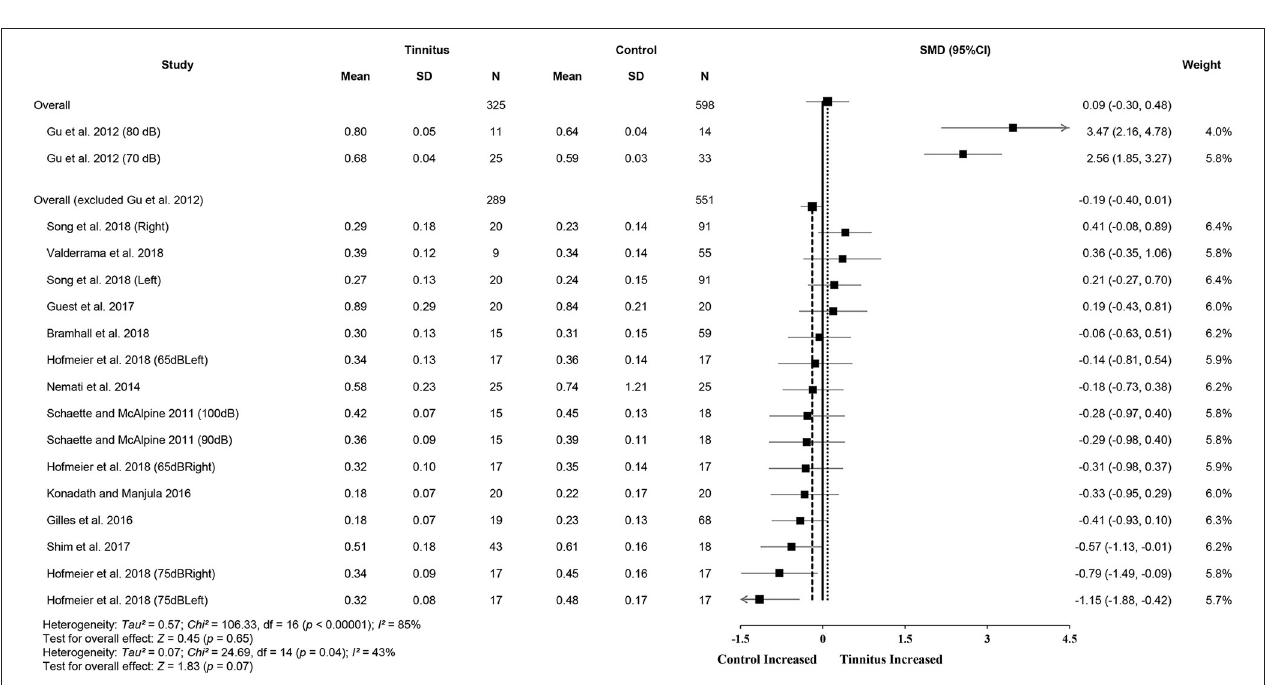
FIGURE 4 | Forest plot of 11 studies for the difference of wave V amplitudes (95% CI) between tinnitus and control